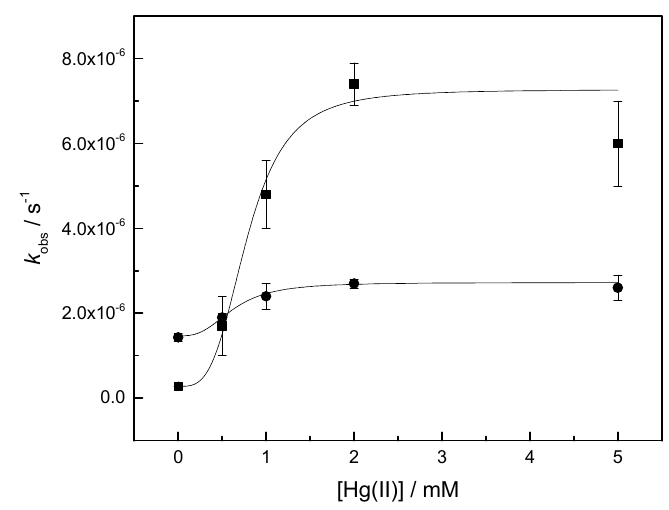
Figure 1. [Hg(II)]-dependence of the rate of cleavage ( k 1 , (cid:4) ) and isomerization ( k 2 + k − 2 , • ) of 1a and 1b ; T = 90 ◦ C; pH = 6.0; [bu ff er] = 30 mM; I (NaNO 3 ) = 100 mM. Table 1. Kinetic parameters for Hg(II)-catalyzed cleavage ( k 1 ) and isomerization ( k 2 + k -2 ) of 1a and 1b ; T = 90 °C; pH = 6.0; [buffer] = 30 mM; I (NaNO 3 ) = 100 mM.